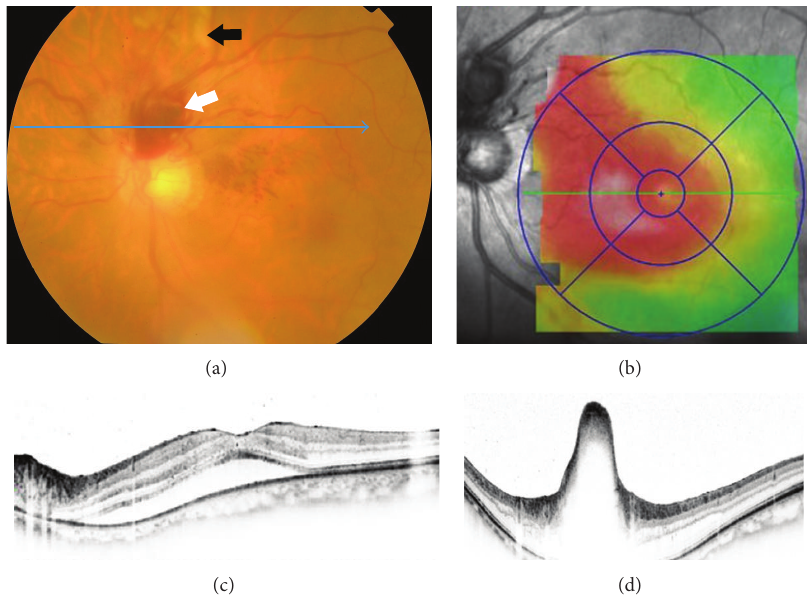
Figure 1: Fundus photograph and spectral-domain optical coherence tomographic (SD-OCT) images of the left eye at the initial visit. (a) Fundus photograph showing an elevated, round, and reddish lesion at the superior aspect of the optic disc (white arrow). Retinal opacification is evident along the course of the superior branch retinal artery (black arrow). Blue arrow indicates the direction of the SD-OCT scan of (d). A mild vitreous opacity is visible. Nerve fiber layer hemorrhages are present superonasal to fovea. (b) Retinal thickness map of SD-OCT shows the retinal thickening extends from the parapaillary region to the macula. (c) SD-OCT scan through the fovea shows serous retinal detachment involving fovea. (d) SD-OCT scan through the red lesion shows marked elevation of the retinal